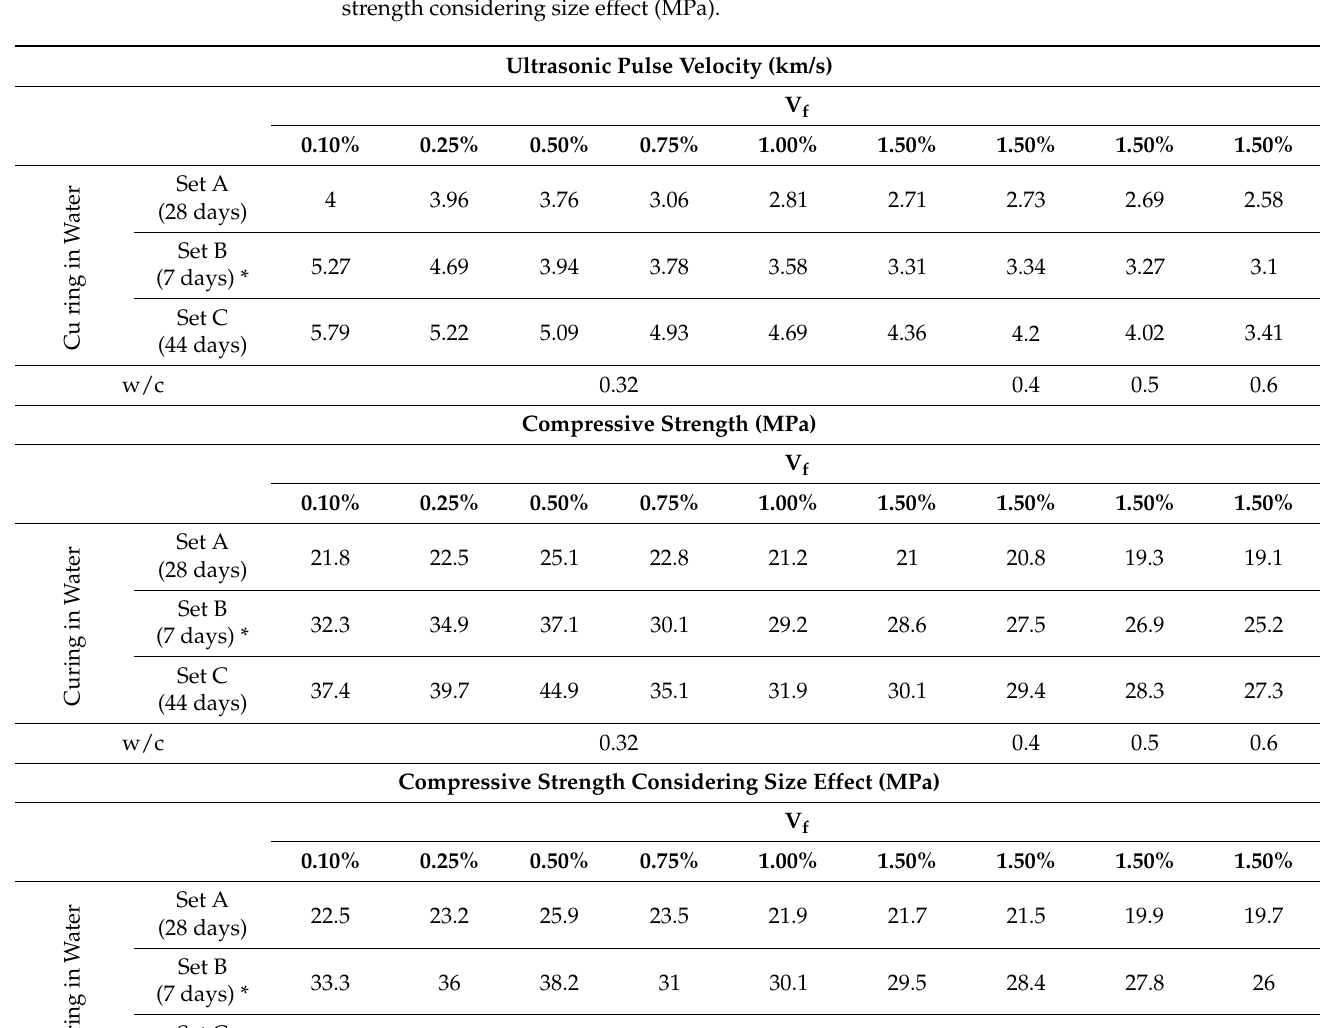
Table 6. Test Results; Ultrasonic pulse velocity (km/s), Compressive strength (MPa), and Compressive strength considering size effect